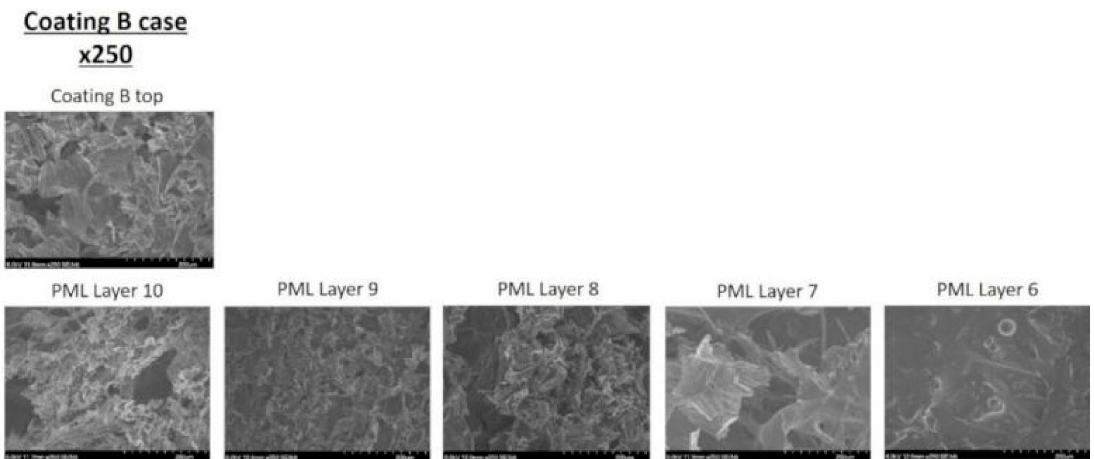
Figure A2. SEM pictures comparing IC-B char to IPML-B chars (taken from layers 10 to